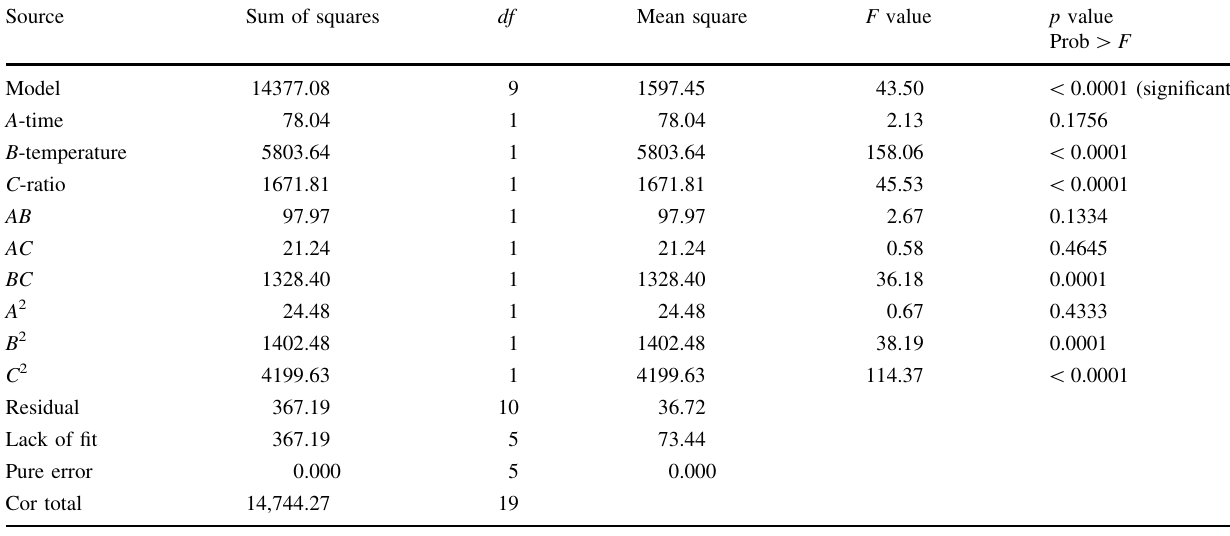
Table 3 Analysis of variance table for CCSFP